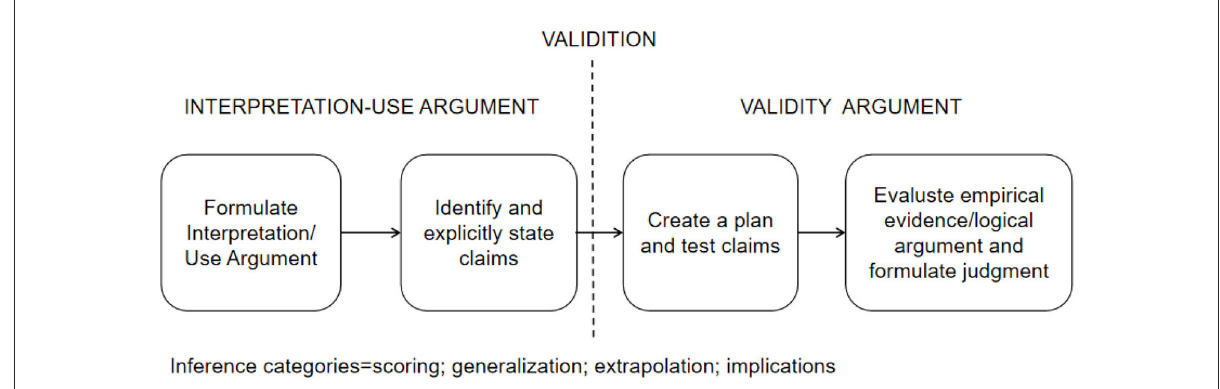
FIGURE1 Schematic illustrating the process of validation, including specification of the inherent claims associated with the interpretation-use argument (from left to right, boxes 1 and 2) and evaluation of those claims (boxes 3 and 4).